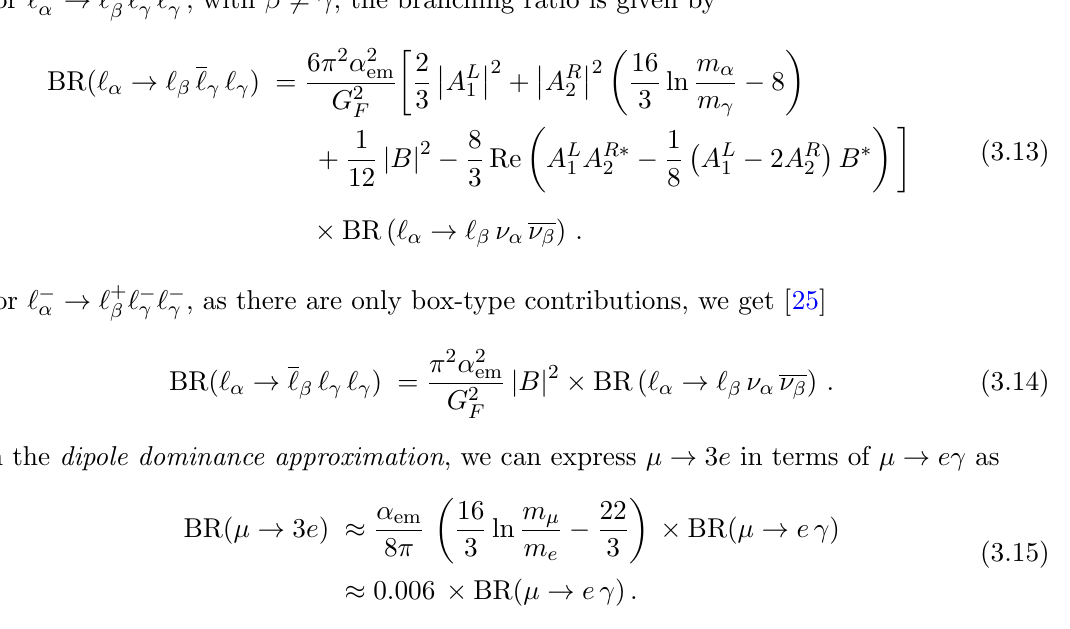
e conversion in (cid:0)